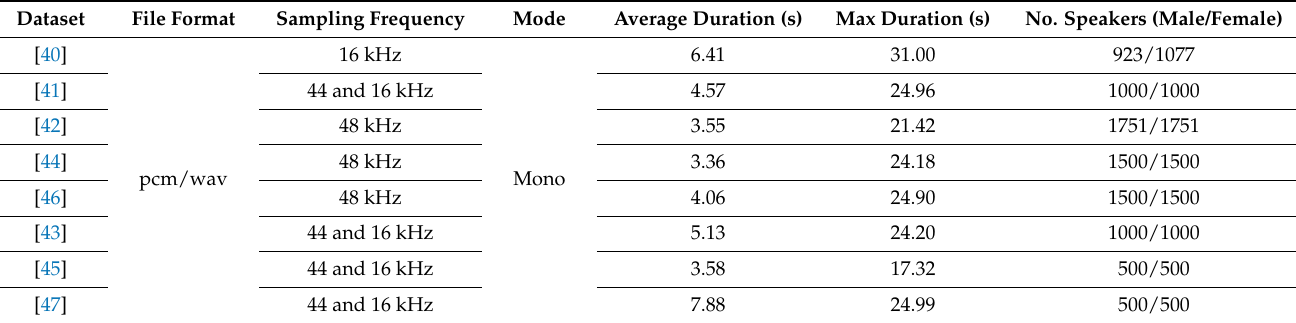
Table 2. The detailed specification of Four Korean speech